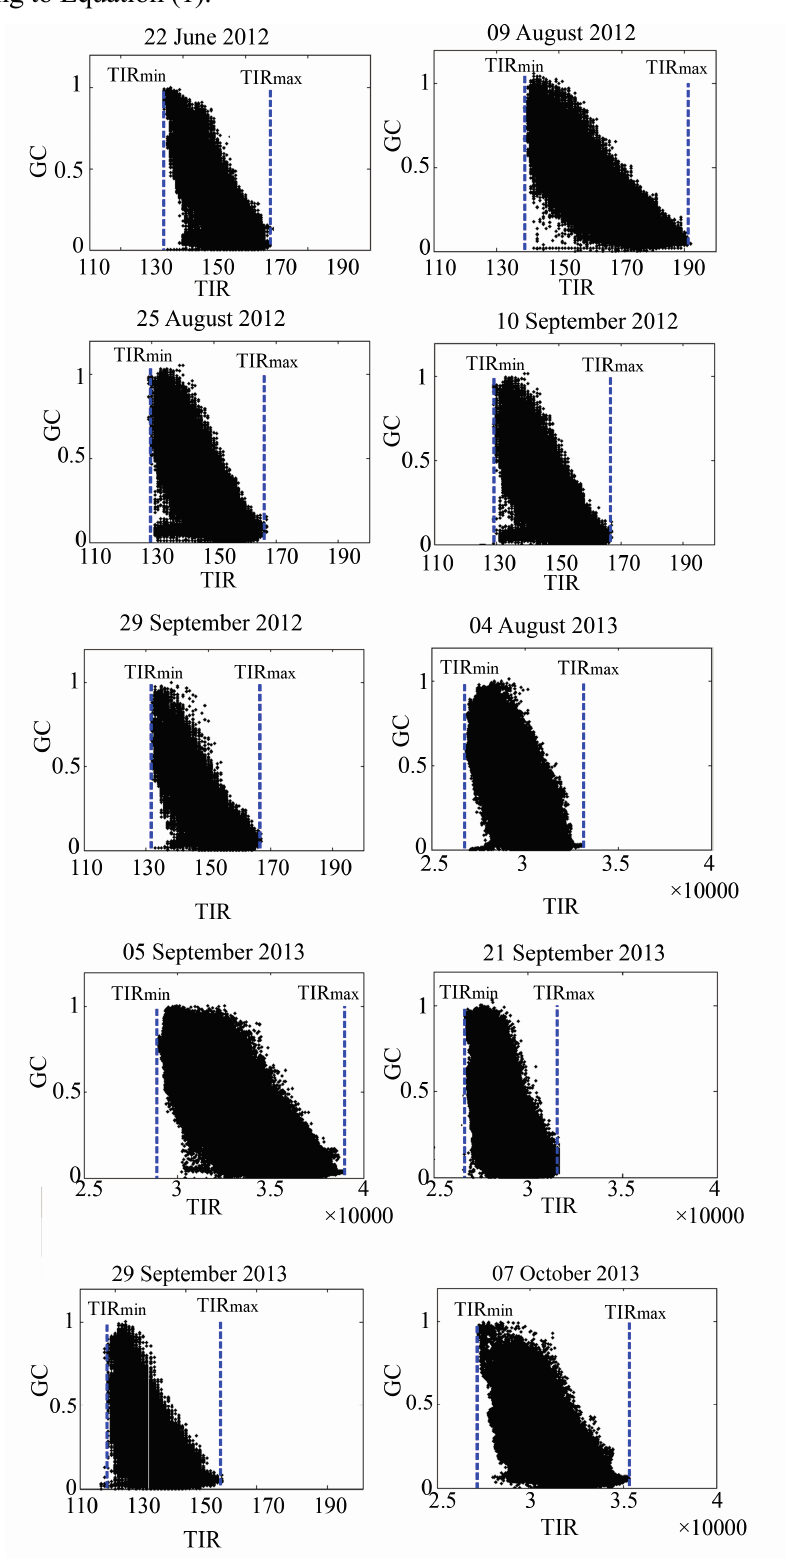
Figure 6. Identification of TIR max and TIR min used to normalized TIR values in the TIR-GC